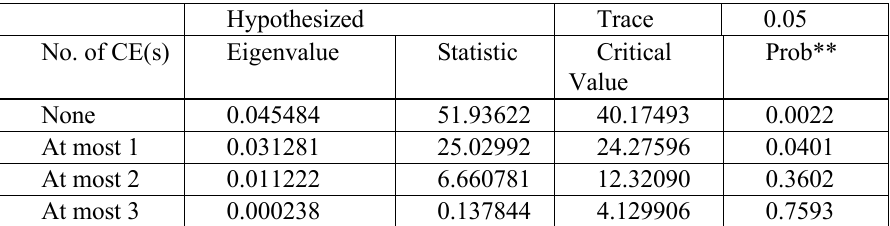
Table 4. Unrestricted Cointegration Rank Test (Trace), Johansen Co-integration test, Series: N NS N5 NS5 Source: Authors’ elaboration